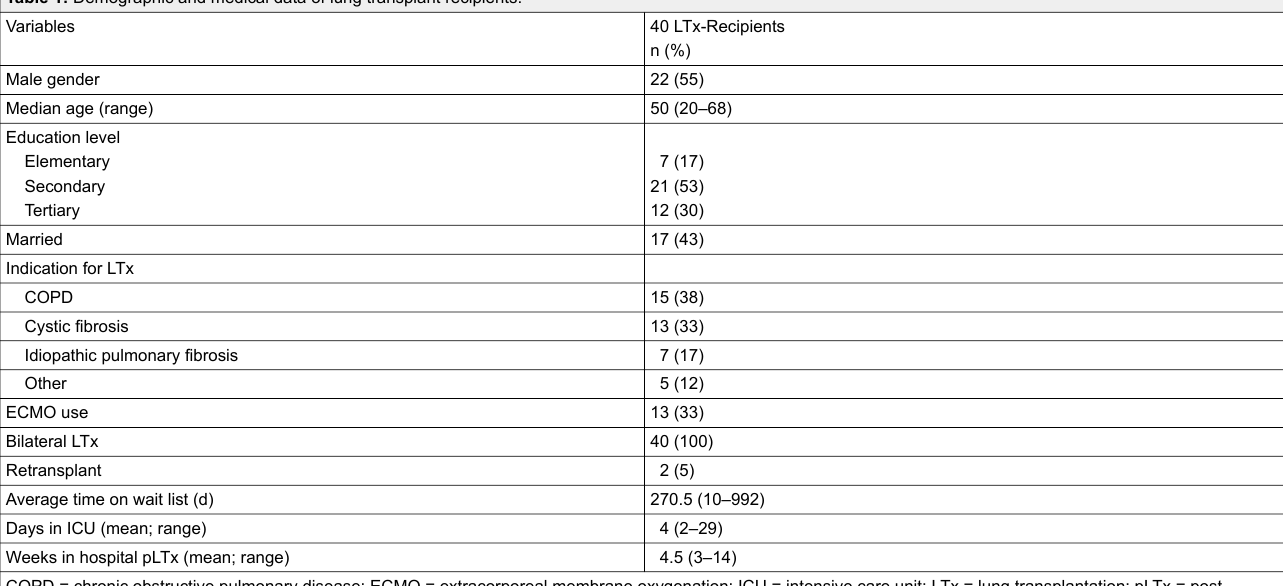
Table 1: Demographic and medical data of lung transplant recipients.